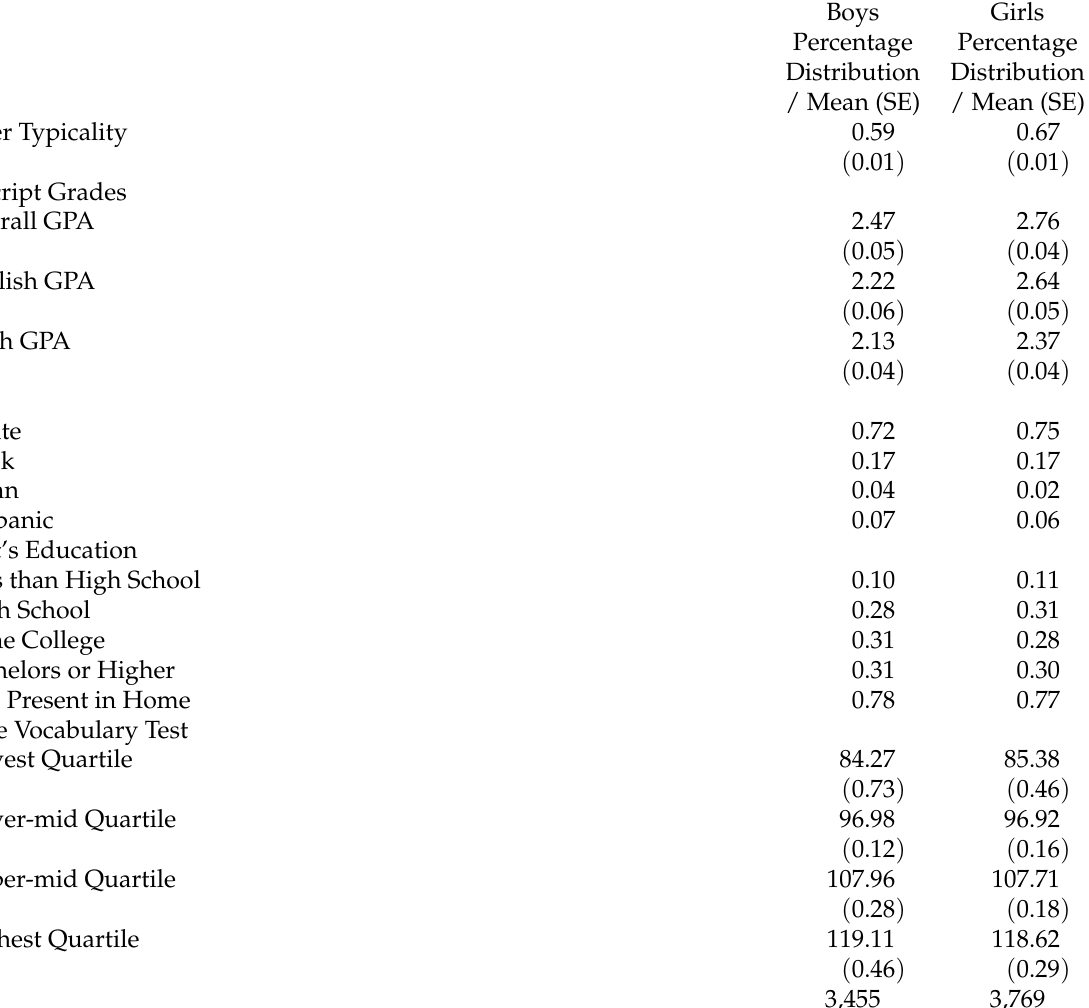
Table 2: Variables used in analysis for boys and